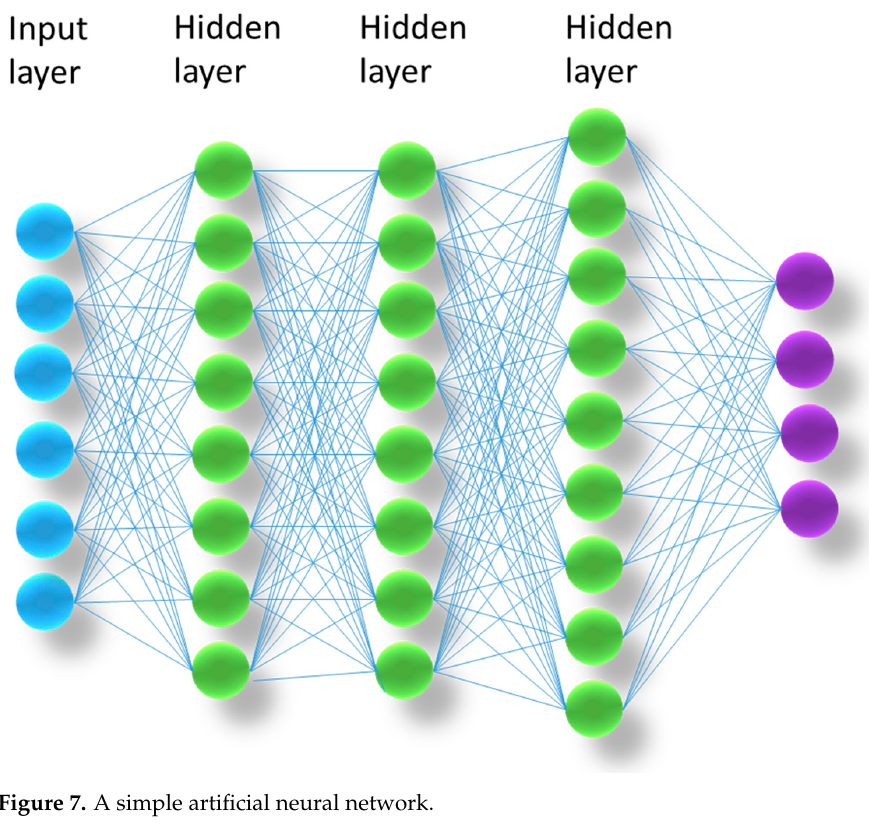
Figure 6. Deep learning is a subfield of machine learning.